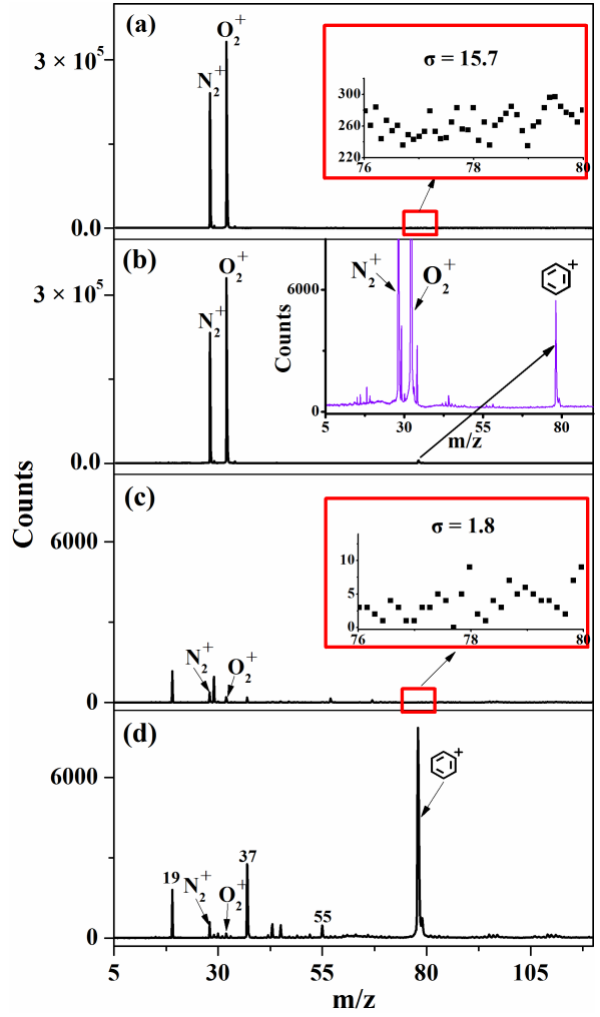
Figure 2. Mass spectra of synthetic air (a) and 8.6ppbv benzene (b) obtained with photoionizer A. Mass spectra of synthetic air (c) and 8.6ppbv benzene (d) obtained with photoionizer B. The acqui- sition time for each mass spectrum is 10s. The insets in Fig. 2a and c show the magnified baselines of the mass spectra at an m/z of 78. The inset in Fig. 2b shows the magnification of the benzene mass